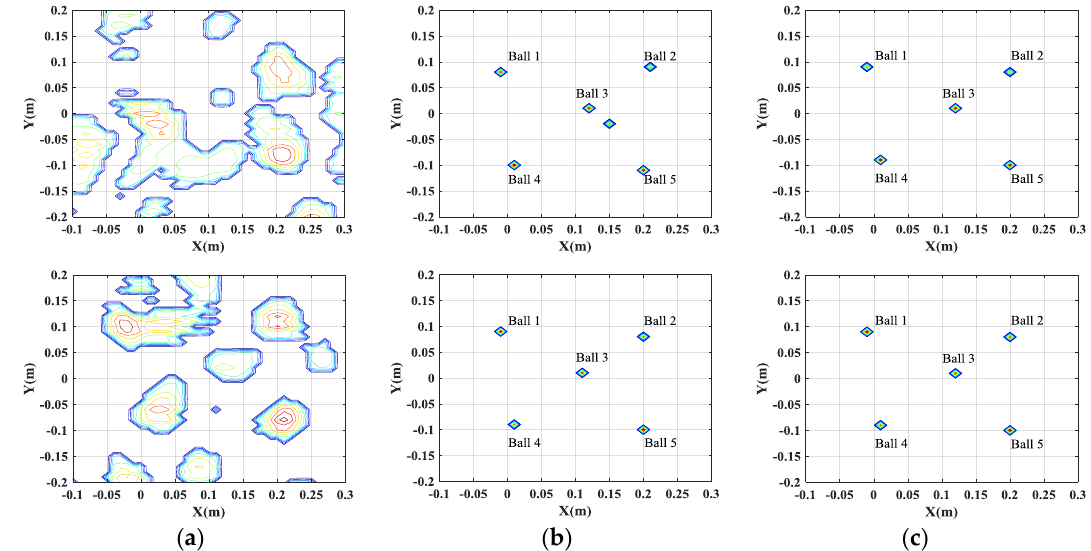
Figure 6. Comparison of imaging results by different imaging methods using 25% of full data. Images in the first row are from the results of channel 1. Images in the second row are from the results of channel 2. ( a ) FBP method; ( b ) single channel CS method; and ( c ) multichannel joint CS method.